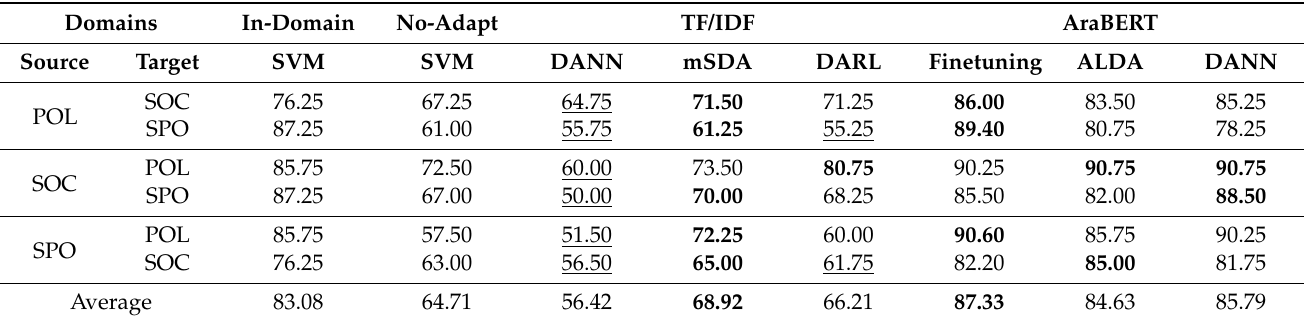
Table 3. The classification accuracy results of in-domain, no adaptation baseline and domain adapta- tion methods on DA (MARSA